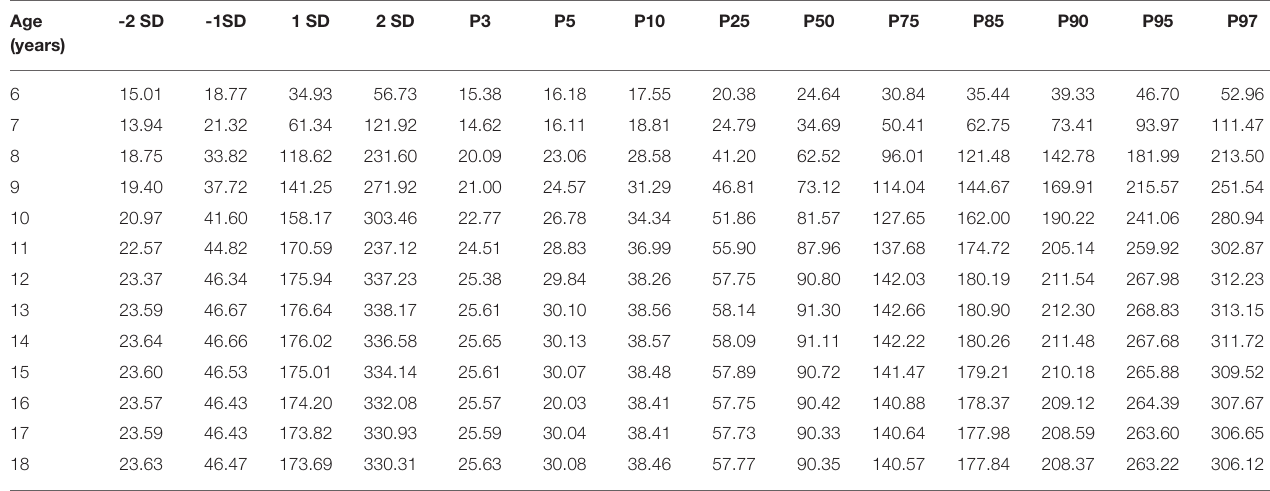
TABLE 2 | SAT-for-age (cm 2 ) references for